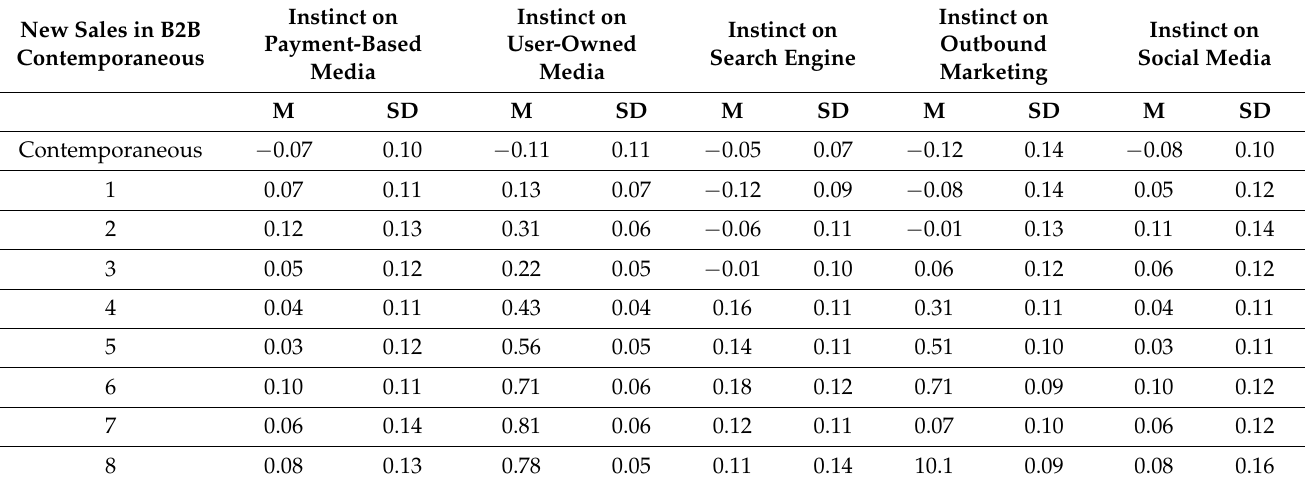
Table 4. Average collective elasticities of different digital medias.